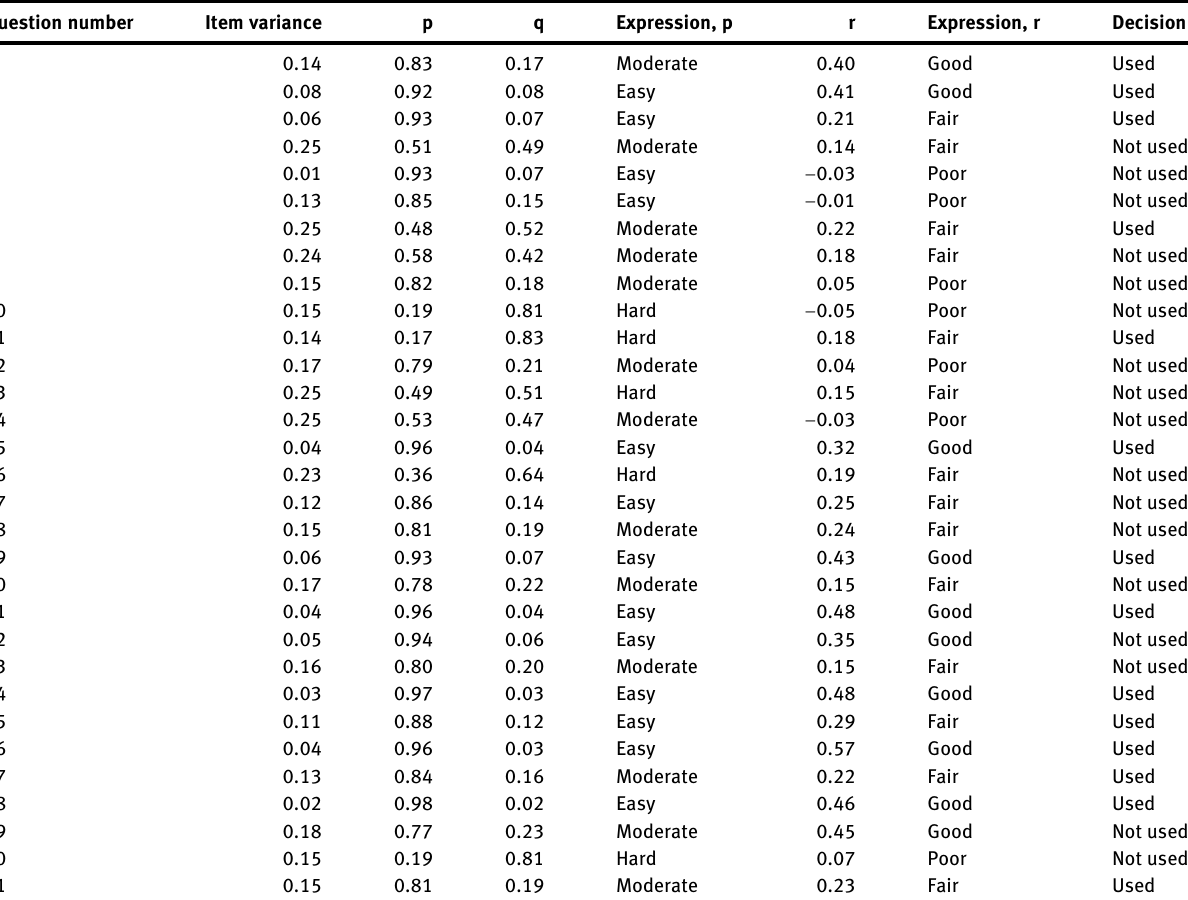
Table  : Items ’ dif fi culty and distinctiveness indexes. Question